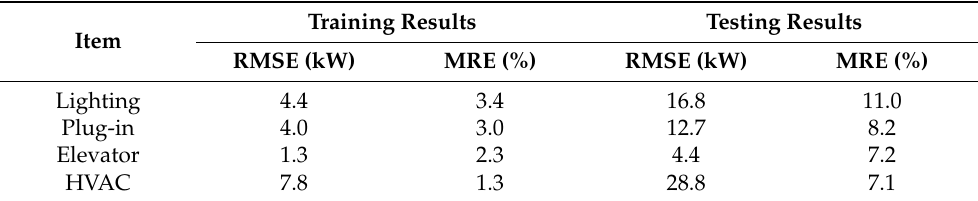
Table 3. Training and testing results of NIM models based on Approach I.